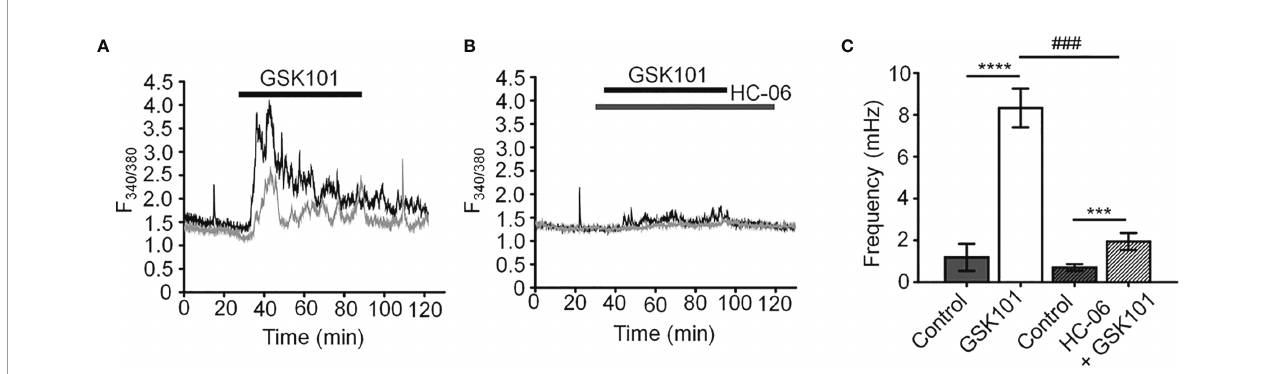
FIGURE 1 | GSK101 triggers intracellular Ca 2+ oscillations in hTM cells. (A) Representative traces of [Ca 2+ ] i oscillations in GSK101 treated TM cells. (B) GSK101- induced oscillations are absent in cells pretreated with HC-06. (C) Quanti fi cation of results shown in (A, B) , shown as average ± S.E.M. ****P < 0.0001, ***P < 0.001